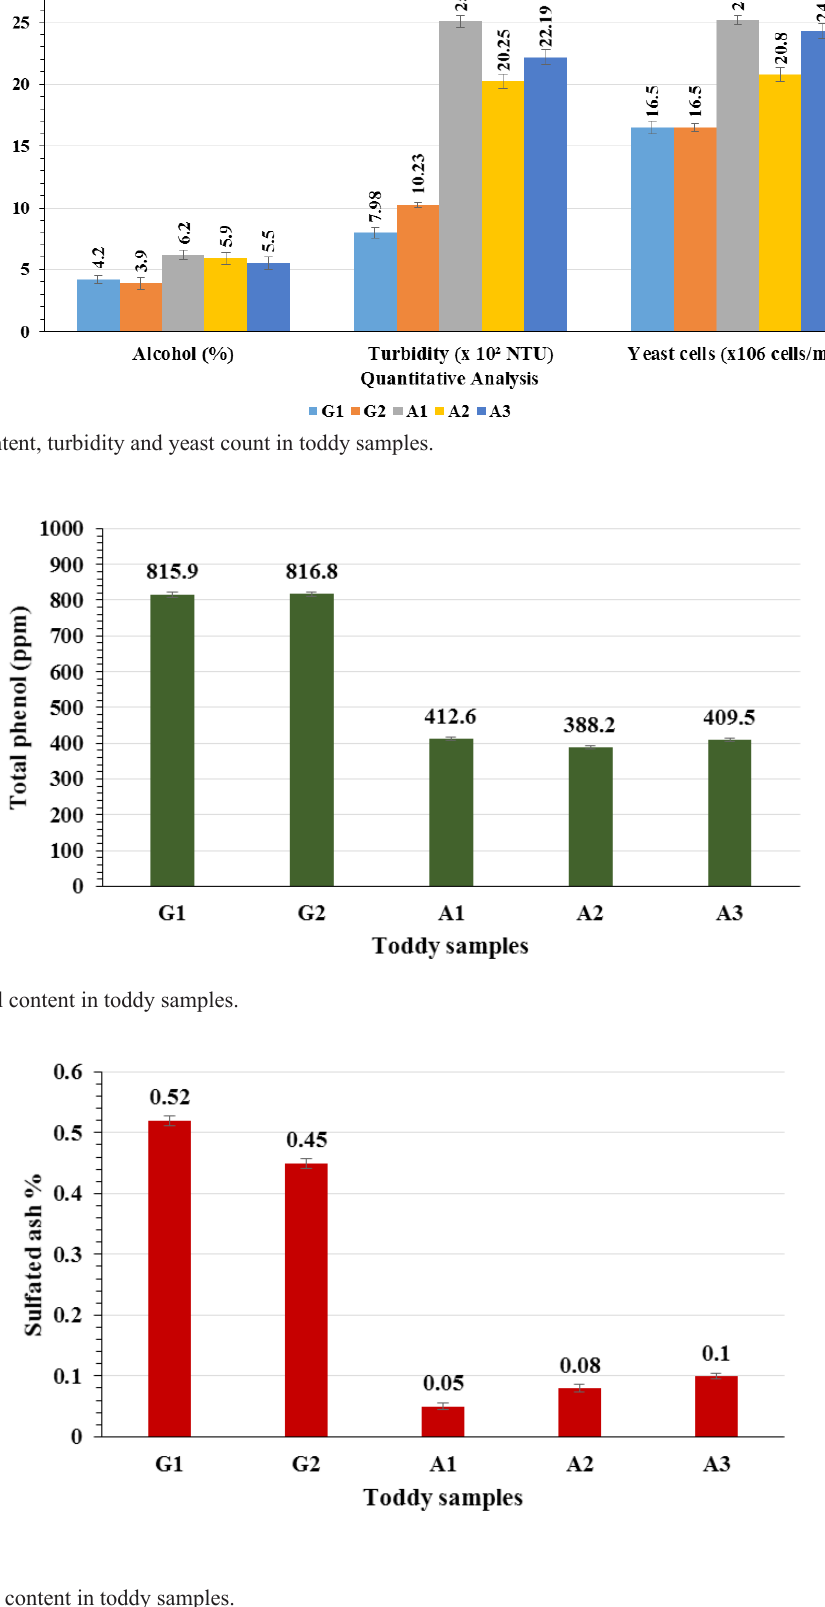
Figure 4: Sulfated ash content in toddy